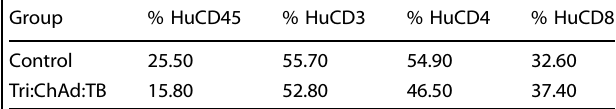
Table 1. Engraftment of human immune cells in humanized